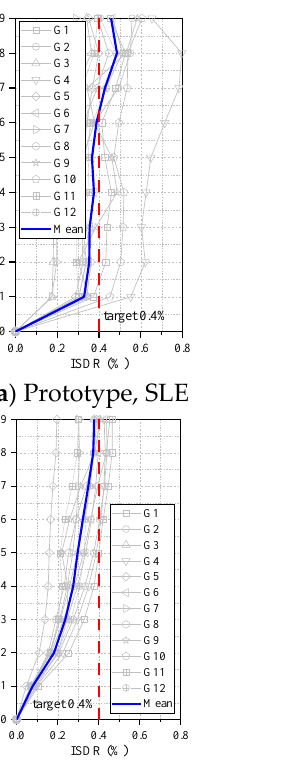
( f ) Enhanced, MCE Figure 17. Inter-story drift ratio of the prototype and the enhanced SMRF.